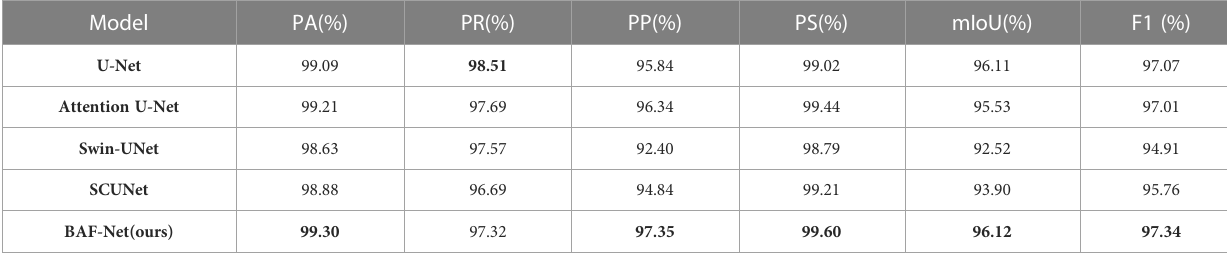
TABLE 5 The segmentation results on the HPL dataset using different models.